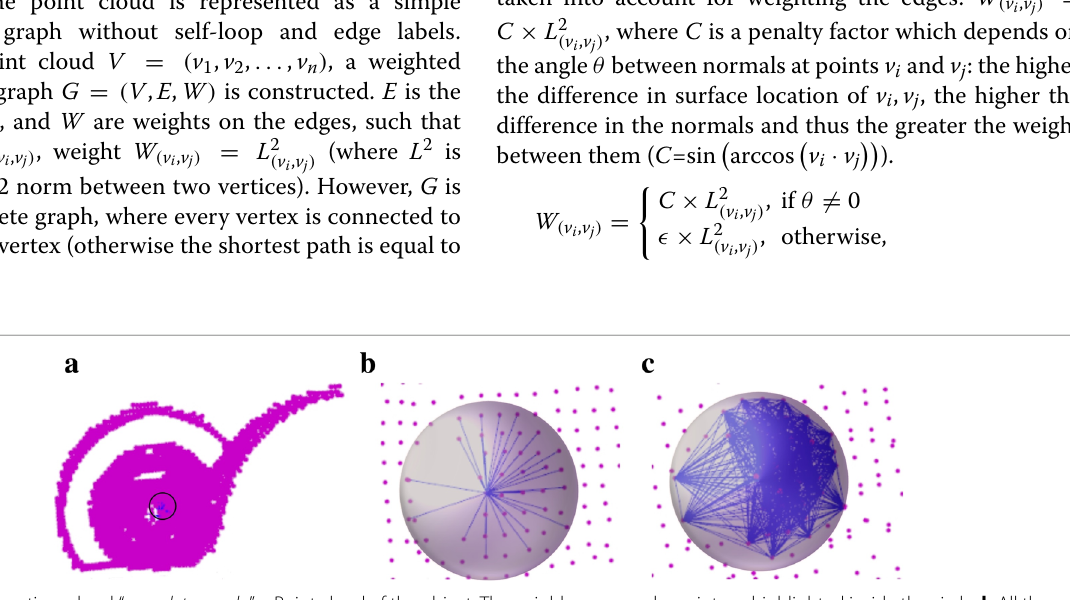
Fig. 11 Constructing a local “ completegraph. ” a Point cloud of the object. The neighbors around a point are highlighted inside the circle. b All the nodes within a sphere of radius ( r = 3.5 × point cloud resolution) are connected to the parent node. c A “complete graph” is constructed within a sphere, where every node is connected to another one by a unique